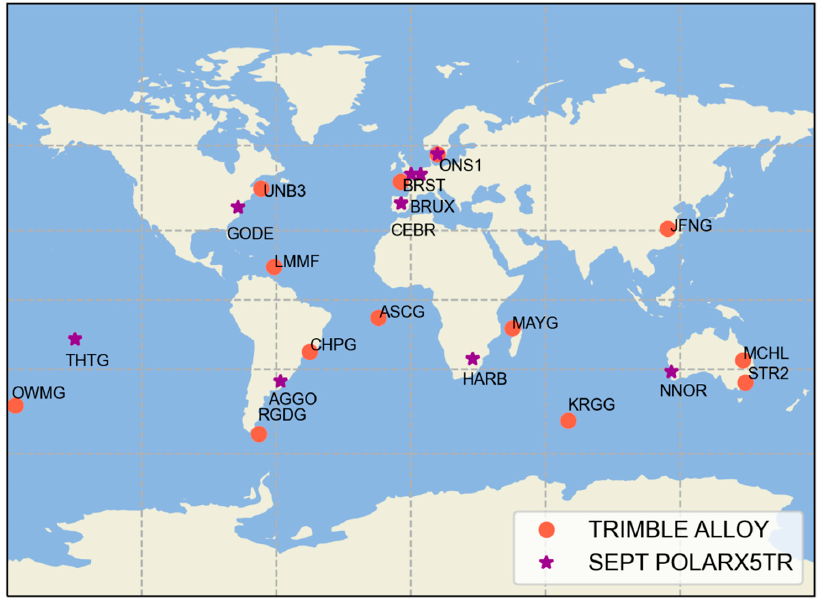
Figure 1. Ground tracking stations, red dots denote 13 SEPT receivers tracking GPS/Galileo Q sig- nals, stars represent 9 TRIMBLE receivers tracking GPS/Galileo X signals